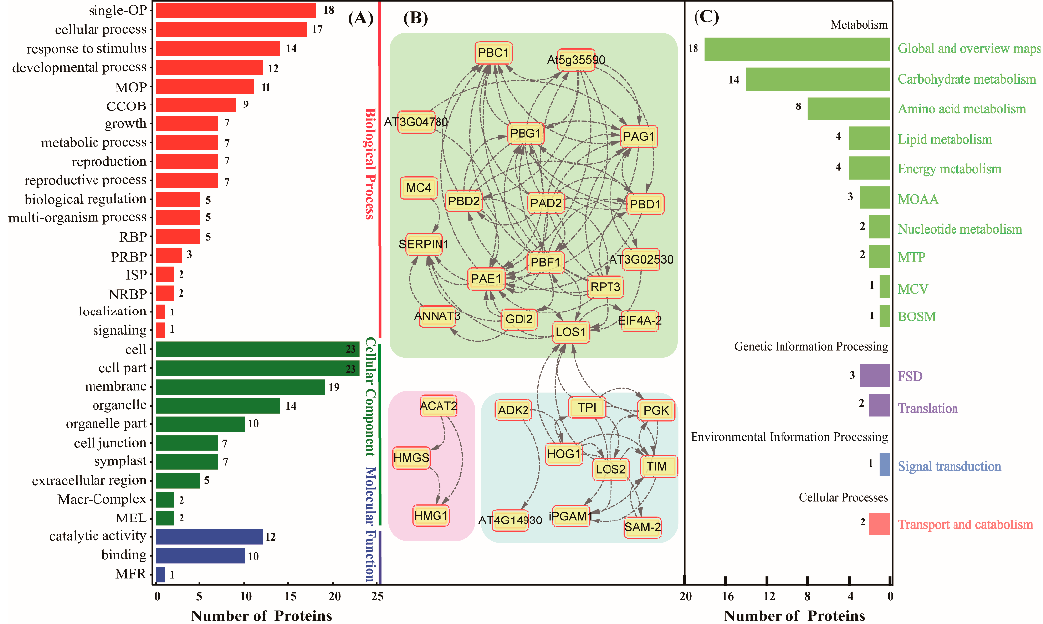
Figure 5. Functional analysis of DAGPs upon ethylene stimulation. The identified 65 DAGPs were exposed to Gene Ontology (GO) ( A ), protein–protein interaction ( B ) and The Kyoto Encyclopedia of Genes and Genomes (KEGG) ( C ) analyses to determine their biological pathways in rubber latex. The abbreviations for these pathways and their detail information are provided in the end section and Table S2.